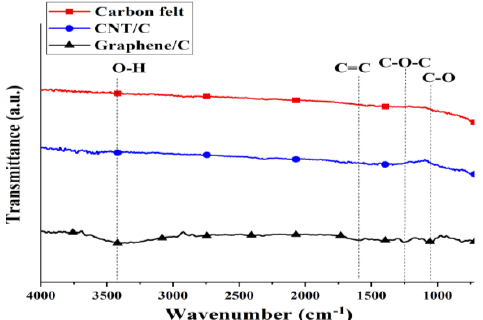
Figure 3. FTIR spectra for different modifications of carbon felt.